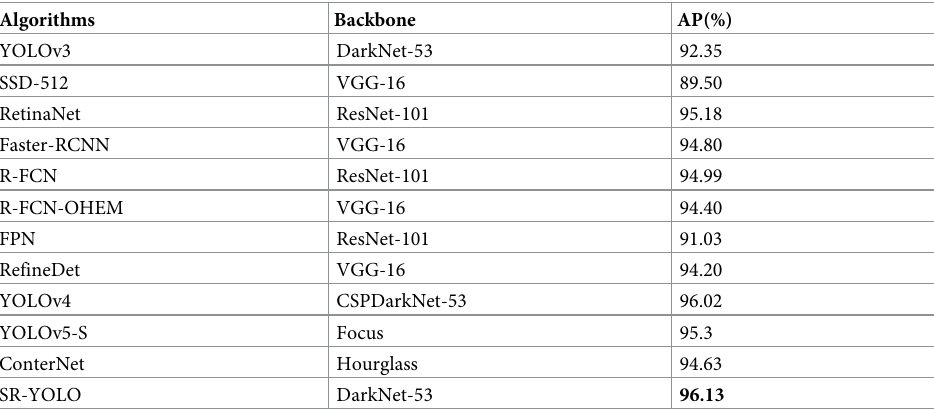
Table 4. AP of different detection algorithms on UCAS-AOD dataset (IOU 0.5).